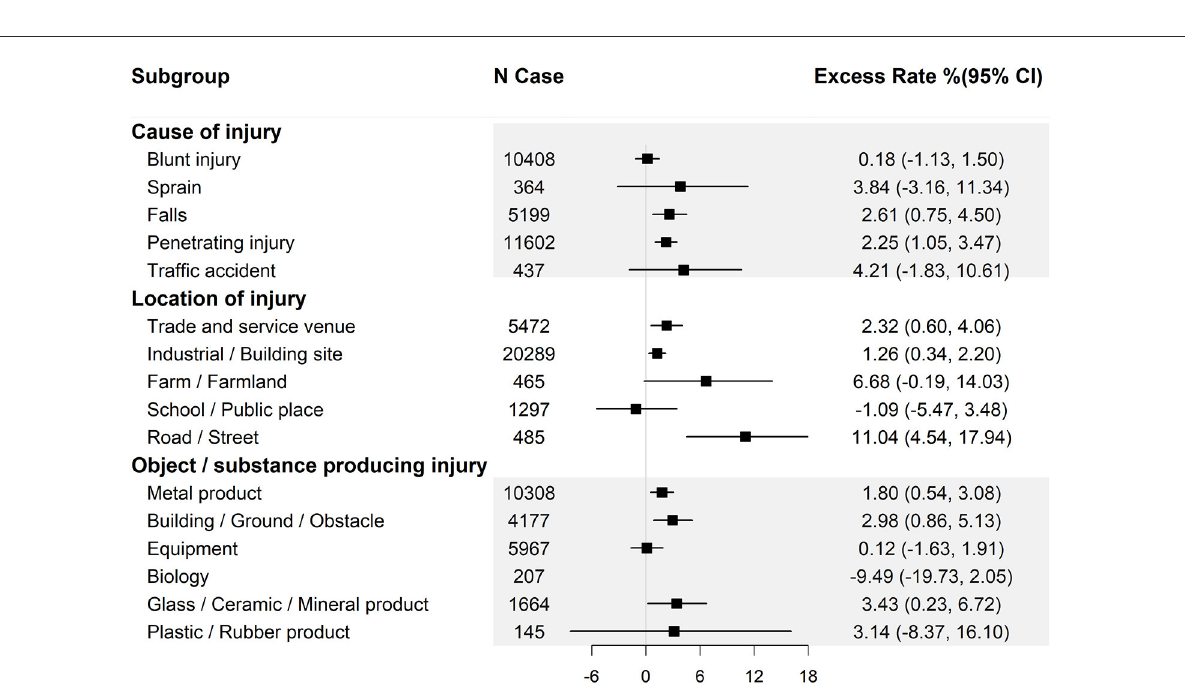
of work performance and the ability to notice work environment hazards (34,